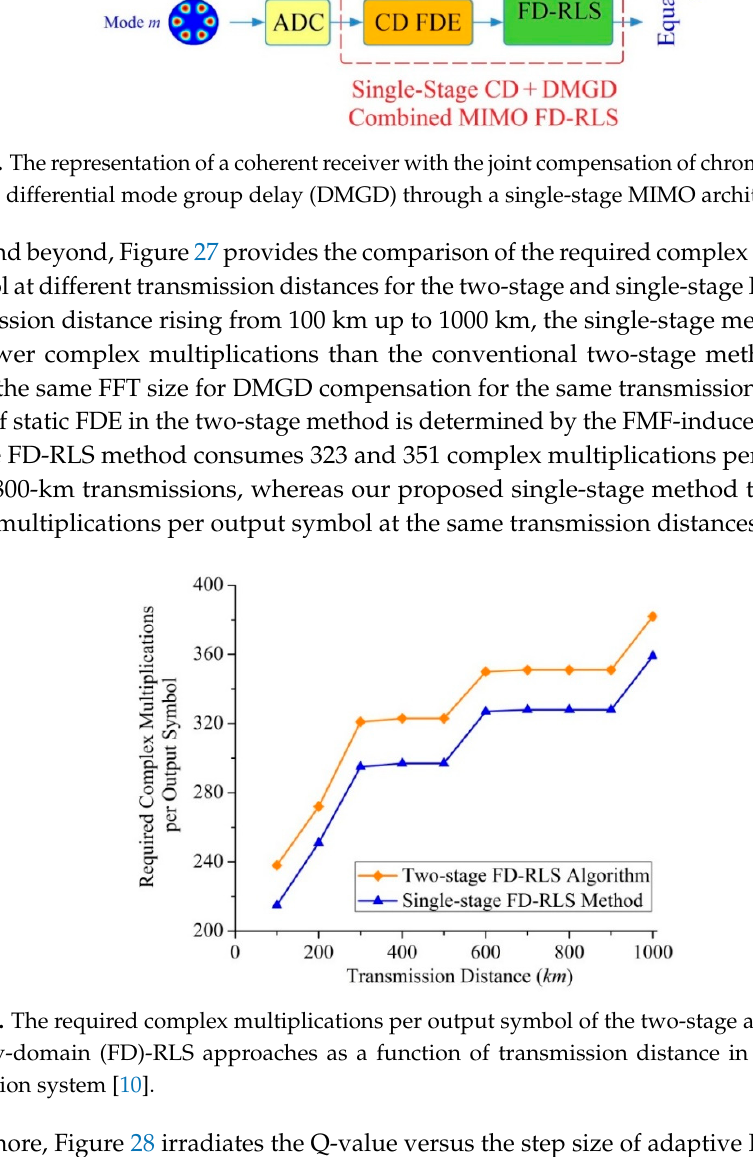
Figure 26. The representation of a coherent receiver with the joint compensation of chromatic dispersion (CD) plus differential mode group delay (DMGD) through a single-stage MIMO architecture [10].